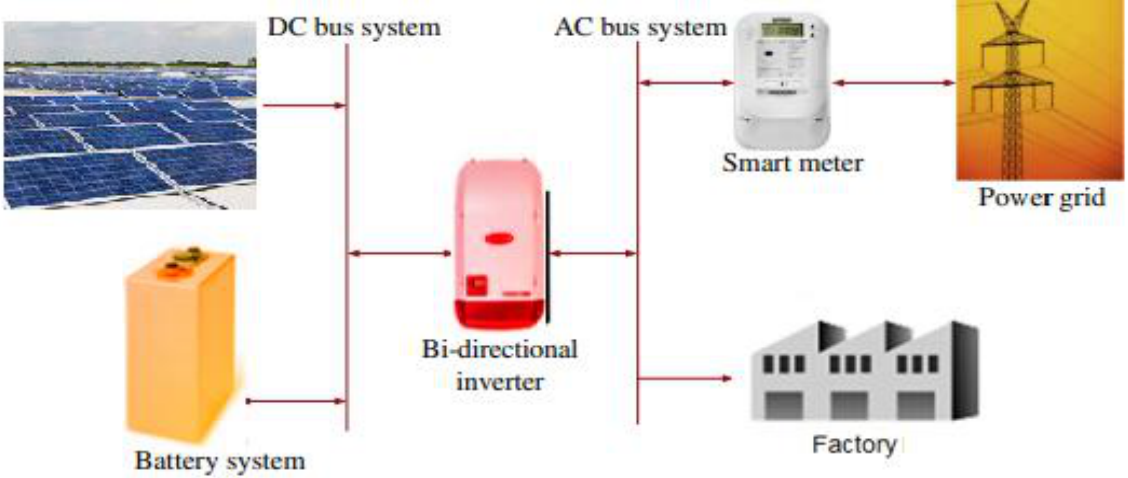
Figure 8. PV on-grid system with storage.